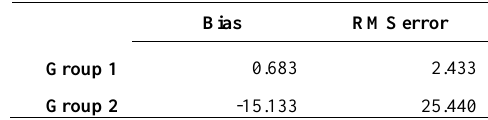
Table 10. Bias and RMS error according to group for tree height data in task 3.